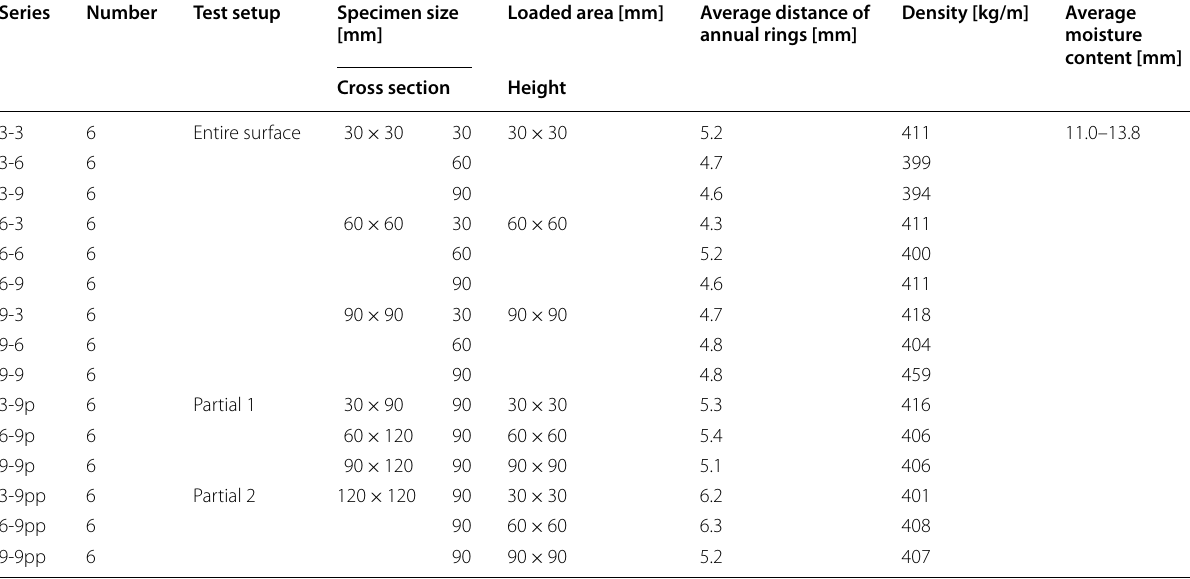
Table 1 Overview of test series of solid timber specimens